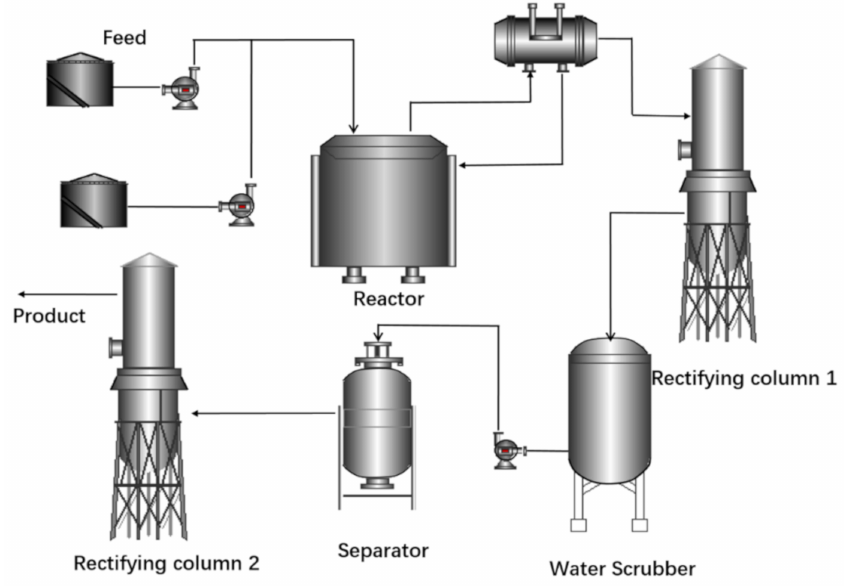
Figure 1. The producing process of